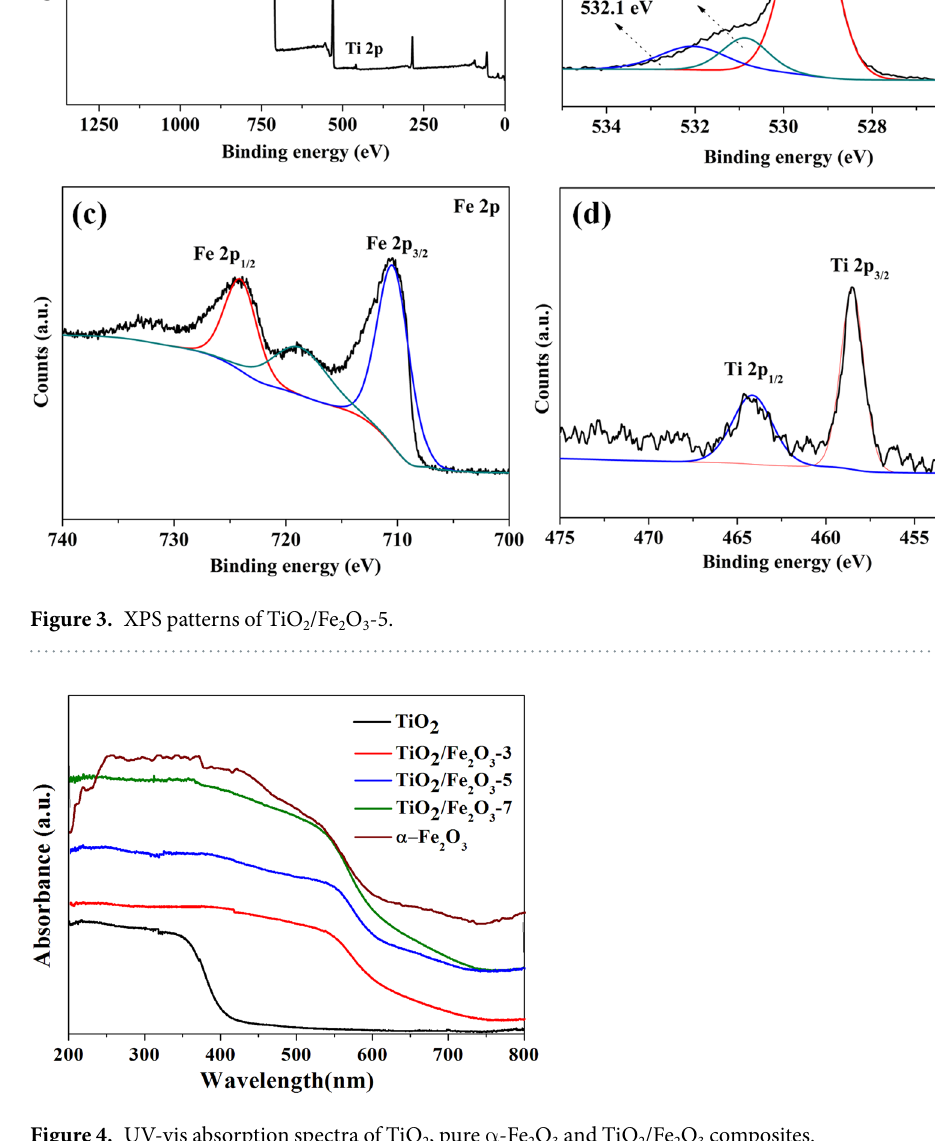
Figure 4. UV-vis absorption spectra of TiO 2 , pure α -Fe 2 O 3 and TiO 2 /Fe 2 O 3